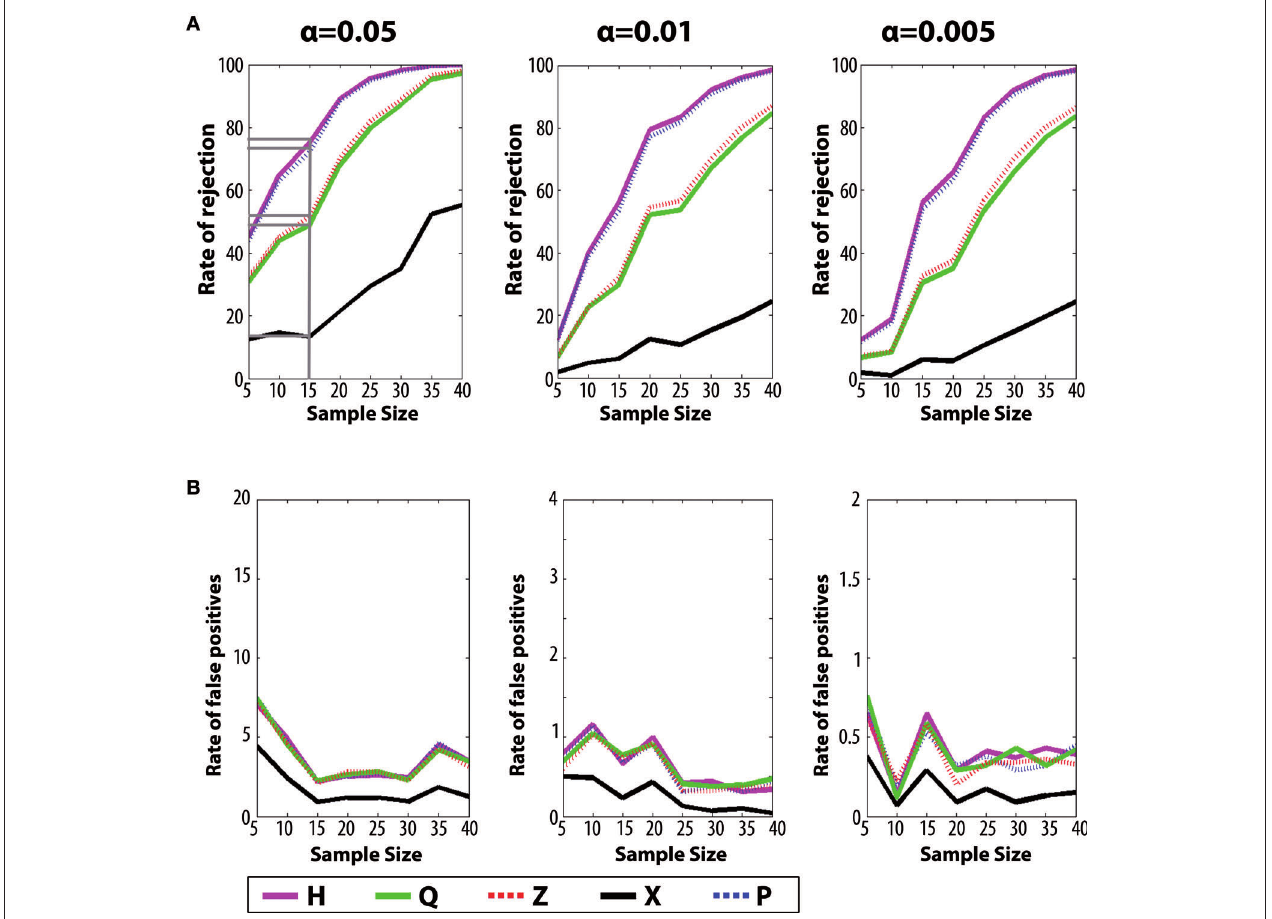
FIGURE 4 | Monte Carlo simulations ( Analysis A ). (A) The likelihood of detecting a difference between control and experimental groups is shown for varying sample ( N ) size, with signifi cance levels α = 0.05, 0.01 and 0.001.